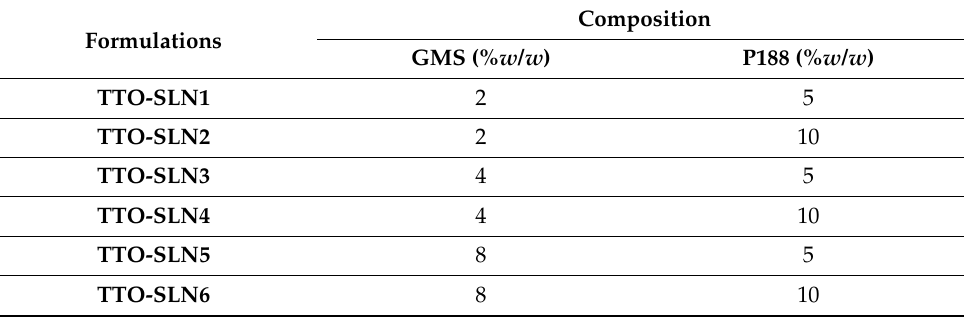
Table 4. Composition of TTO-loaded SLNs. Formulations